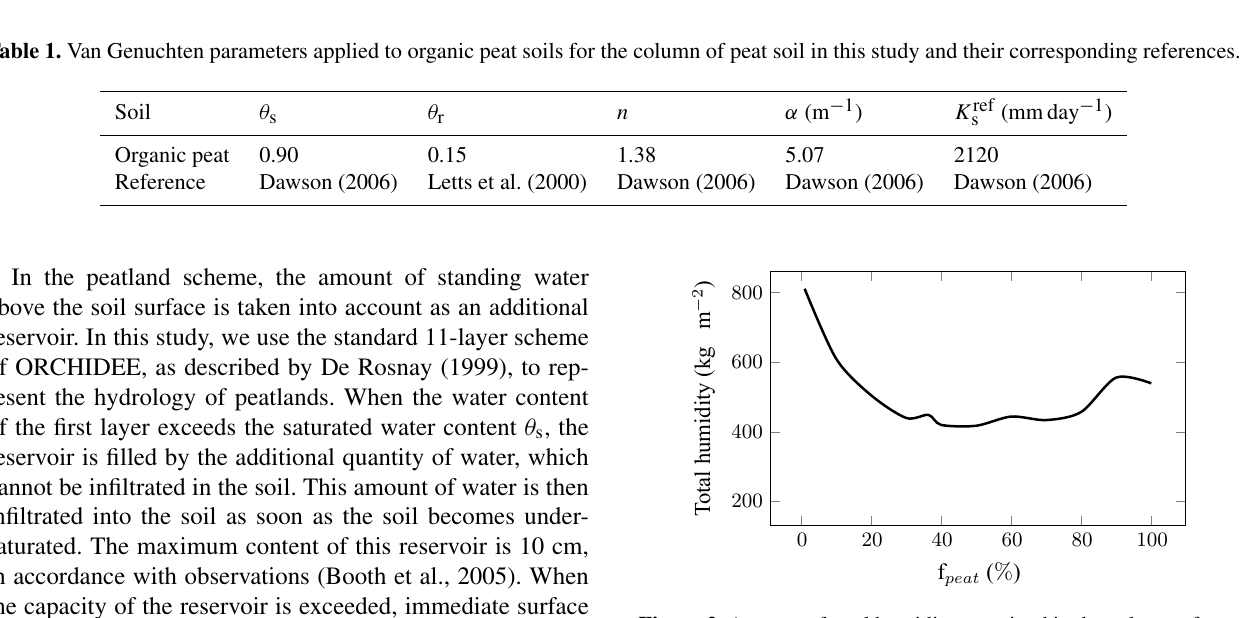
Figure 2. Amount of total humidity contained in the column of peat soil of 2m depth at the Degero site in 2001 as a function of the percentage of peatland imposed in a grid